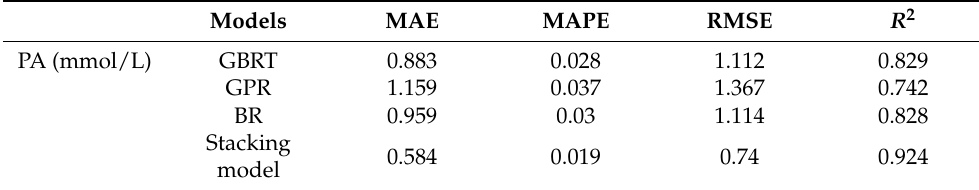
Table 4. Comparison of propionic acid (PA) prediction performances of different